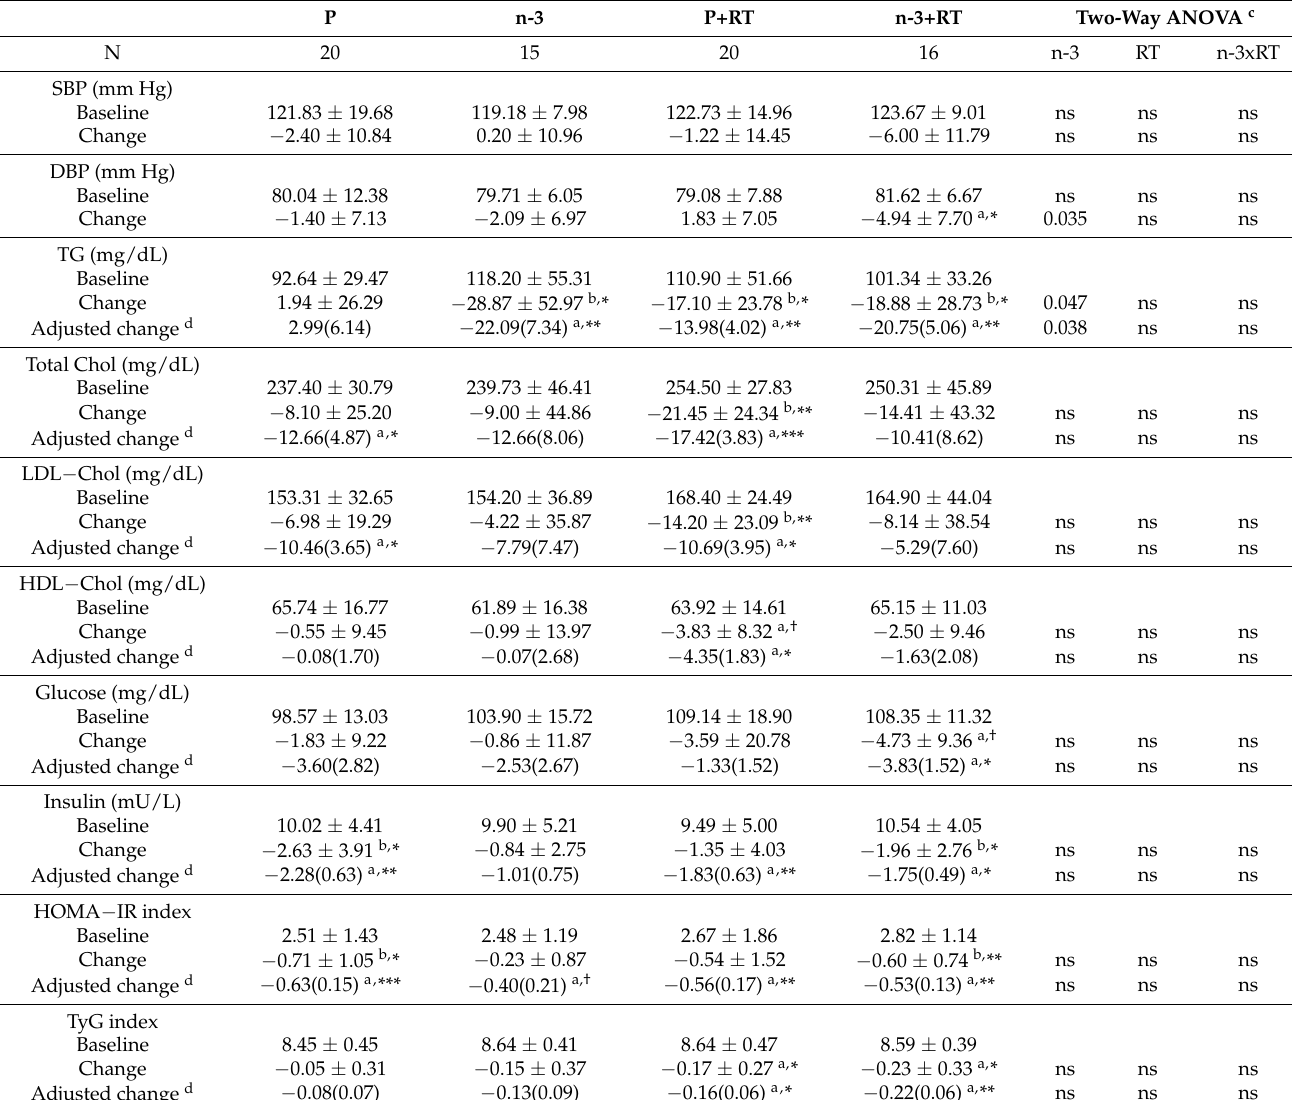
Table 3. Effects of 16 weeks of DHA-rich n-3 PUFA (n-3) supplementation and/or resistance training (RT) on blood pressure and glucose and lipid metabolism biomarkers in overweight/obese postmenopausal